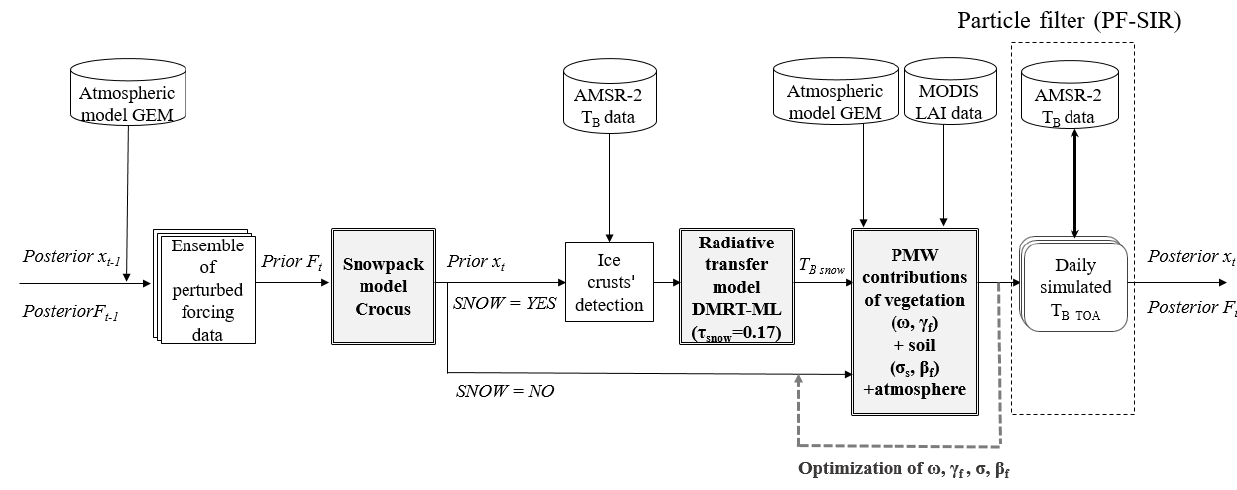
Figure 2. Methodological scheme describing the DA scheme in the chain of models for SWE retrievals by updating perturbed atmospheric forcing data and snowpack states (“ F t ” and “ x t ”, respectively; see Sect. 3.4). Table 1. Characteristics of the nivometric SWE stations: site number, latitude (Lat.), longitude (Long.) and elevation (El., a.s.l. in meters) of stations. Dist. GEM–station is the distance between the station and the center of the associated GEM grid cell (with GEM, Global Environmental Multiscale weather prediction model; Sect. 2.2). The time period of observations, average of the maximum observed data over the studied period, and data provider are given (HQ: Hydro-Québec, U. Sherb: University of Sherbrooke, U. Laval: University of Laval). Sites Lat. Long. El. Dist. GEM– Time period Mean maximum Data no. station (km) SWE value (kgm − 2 ) provider